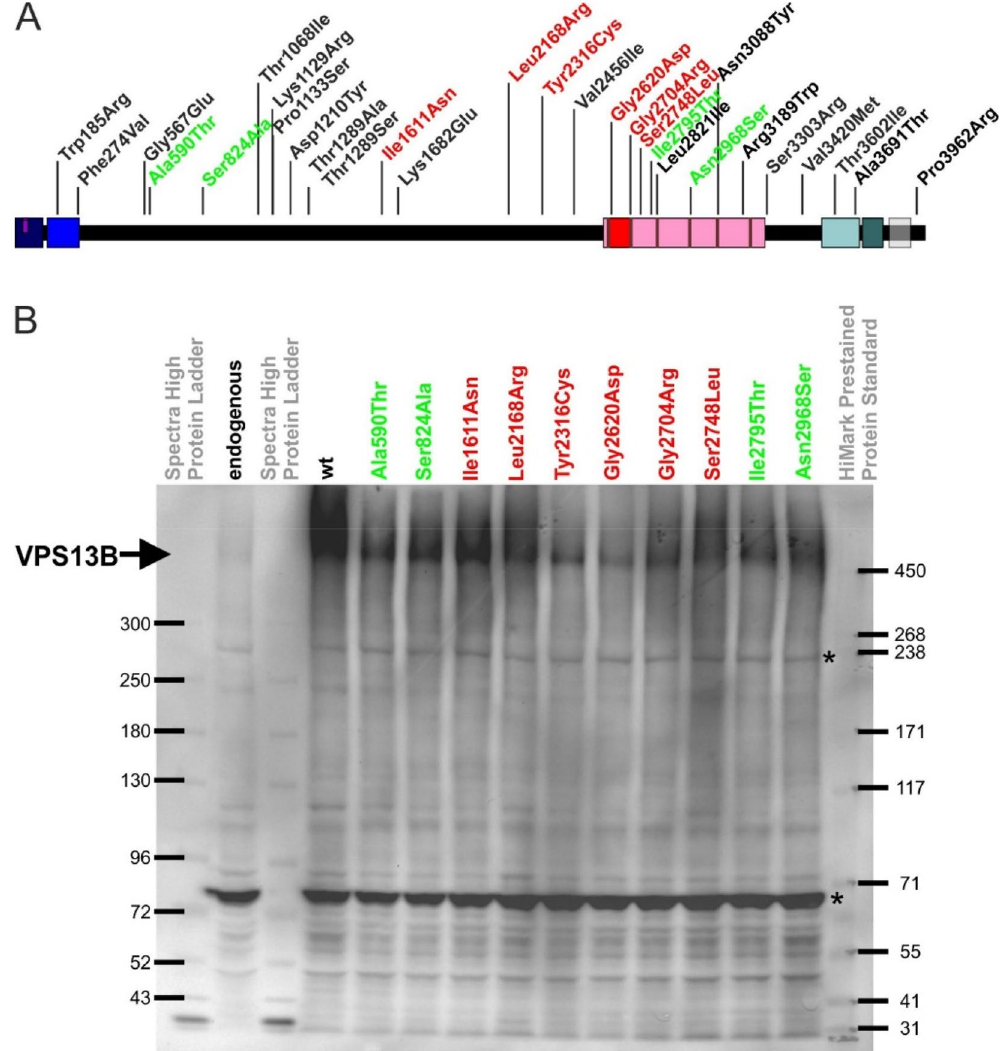
Figure 1. Protein stability of overexpressed wildtype and mutant VPS13B proteins. ( A ) Schematic representation of the VPS13B protein and localization of disease-associated missense variants. Potential functional or homology domains are indicated as follows: Dark blue: a Chorein/VPS13 region at the very N-terminus (aa 3–102, pfam12624), Blue: a second VPS13-N-terminal region (aa 139–280, pfam16908), Red: a Vps13-adaptor binding (VAB) domain (formerly known as classical DUF1162 or SHR-binding domain, aa 2603–2702), Pink: an extended VAB domain (aa 2715–3363, pfam06650) 43 , Mint: a VPS13-C-terminal region (aa 3543–3709, pfam16909), and Dark mint: an autophagy-related protein C terminal domain (aa 3713–3816, pfam09333). Color-coded VPS13B missense variants were in vitro analyzed for their Golgi complex association. Missense variants with Golgi association are green while missense variants which fail to associate at the Golgi complex are red. ( B ) HeLa cells were transfected with pcDNA3.1_VPS13B constructs. 24 h post-transfection cells were collected in RIPA lysis buffer, total protein concentration per lane was adjusted and lysates were processed for SDS-PAGE/Western blot analysis by VPS13B. Arrow indicates VPS13B at 450 kDa. *Indicates previously described false positive signals of the VPS13B (442) antibody 6